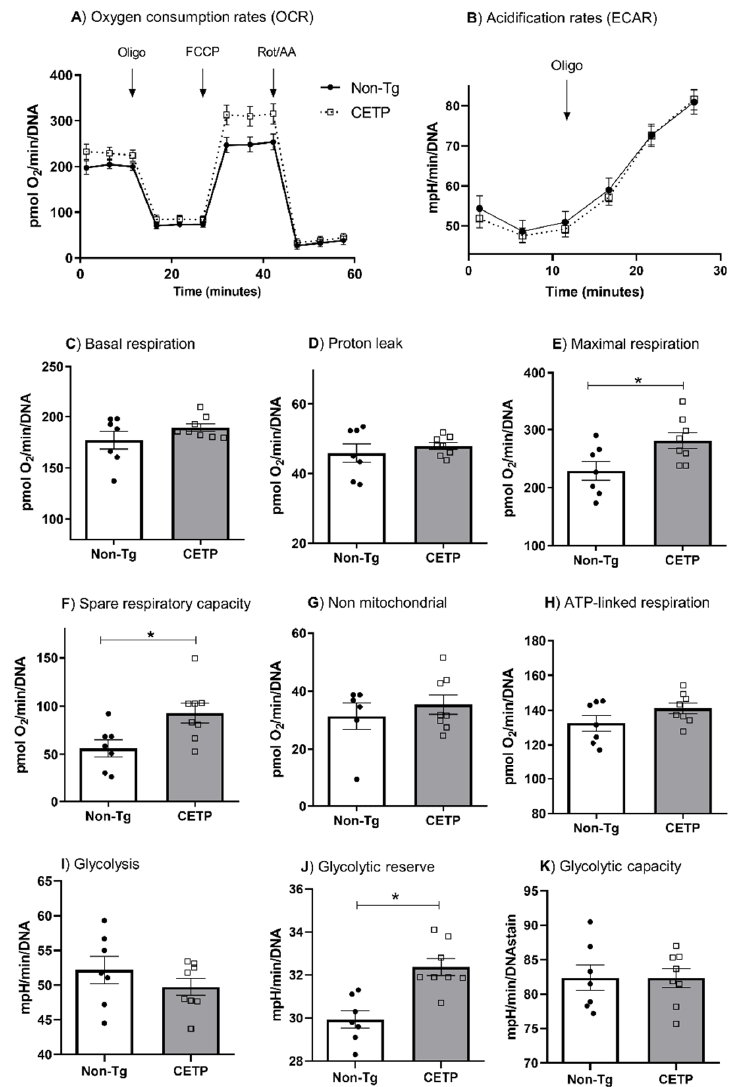
Figure 2. CETP expression in macrophages increases mitochondrial maximal respiration rate, spare respiratory capacity and glycolytic reserve. Oxygen consumption rates (OCR) and extracellular acidification rates (ECAR) were determined in thioglycolate ‐ elicited peritoneal macrophages from human CETP transgenic mice and non ‐ transgenic mice (Non ‐ Tg). ( A ) Average curve of OCR with sequential additions of oligomycin (1 μ M), FCCP (1.25 μ M), and rotenone/antimycin A (1 μ M); ( B ) Average curve of ECAR with oligomycin (1 μ M); ( C ) basal respiration; ( D ) proton leak; ( E ) maximal respiration; ( F ) spare respiratory capacity; ( G ) non ‐ mitochondrial respiration; ( H ) ATP ‐ linked respiration; ( I ) glycolysis; ( J ) glycolytic reserve; ( K ) glycolysis capacity. * p < 0.05.